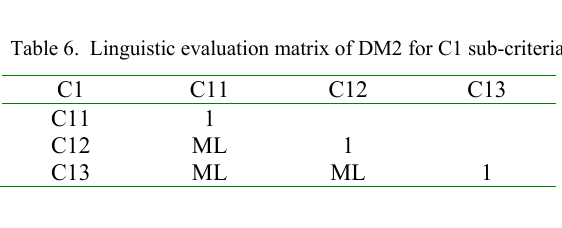
Table 7. Linguistic evaluation matrix of DM3 for C1